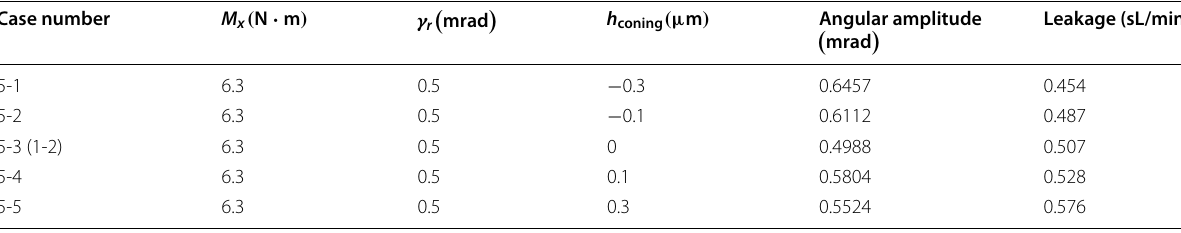
Table 6 Group 5: Varying coning tap